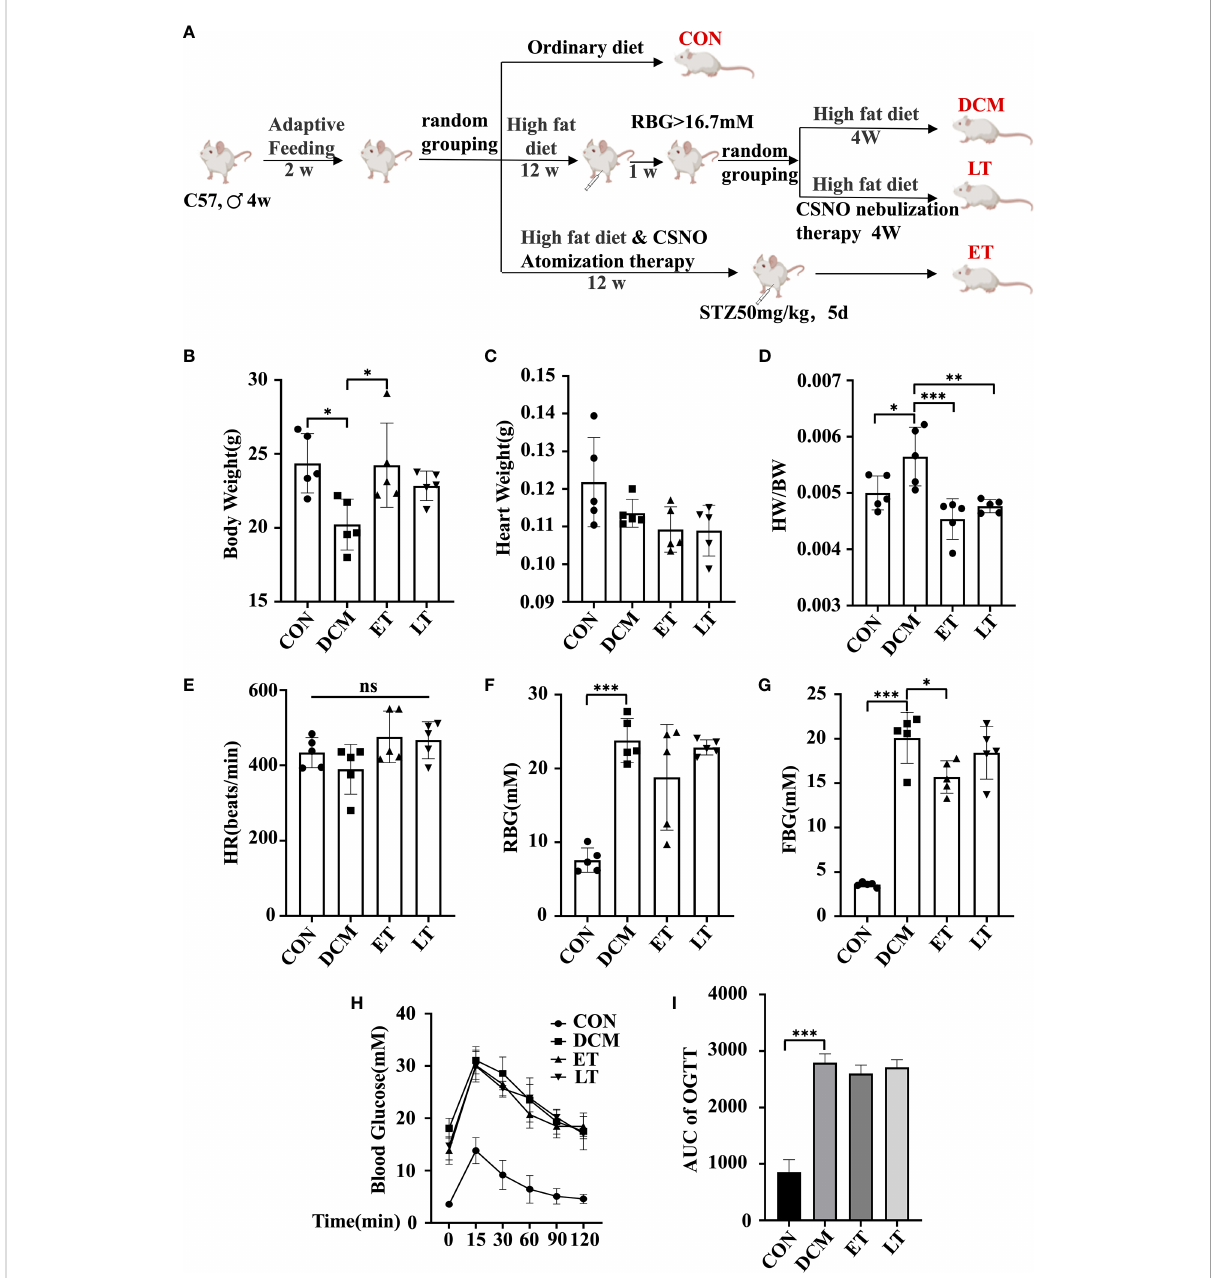
FIGURE 1 Mouse body weight,heartweightandbloodglucose levels. (A) A fl owchartshowingtheexperimental processformodelingmice. (B) Body weightof mice. (C) Heartweightofmice. (D) Heartweight tobody weight ratio(HW/BW). (E) Heartrate(HR). (F) Randombody glucose(RBG). (G) Fastingbloodglucose levels (FBG). (H) Afterfastingfor16hours, miceweregivenglucose solutionby gavage,andthecorrespondingbloodglucose valuesweremeasuredat differenttimepoints.Thecorrespondingcurve wasdrawn, namely, anoral glucosetolerance test (OGTT)curve. (I) Theareaunderthecurve (AUCglucose) wasquanti fi ed. *representsp< 0.05;**representsp< 0.01;***representsp< 0.001. The “ ns ” symbol stands for “ nosigni fi cance ”